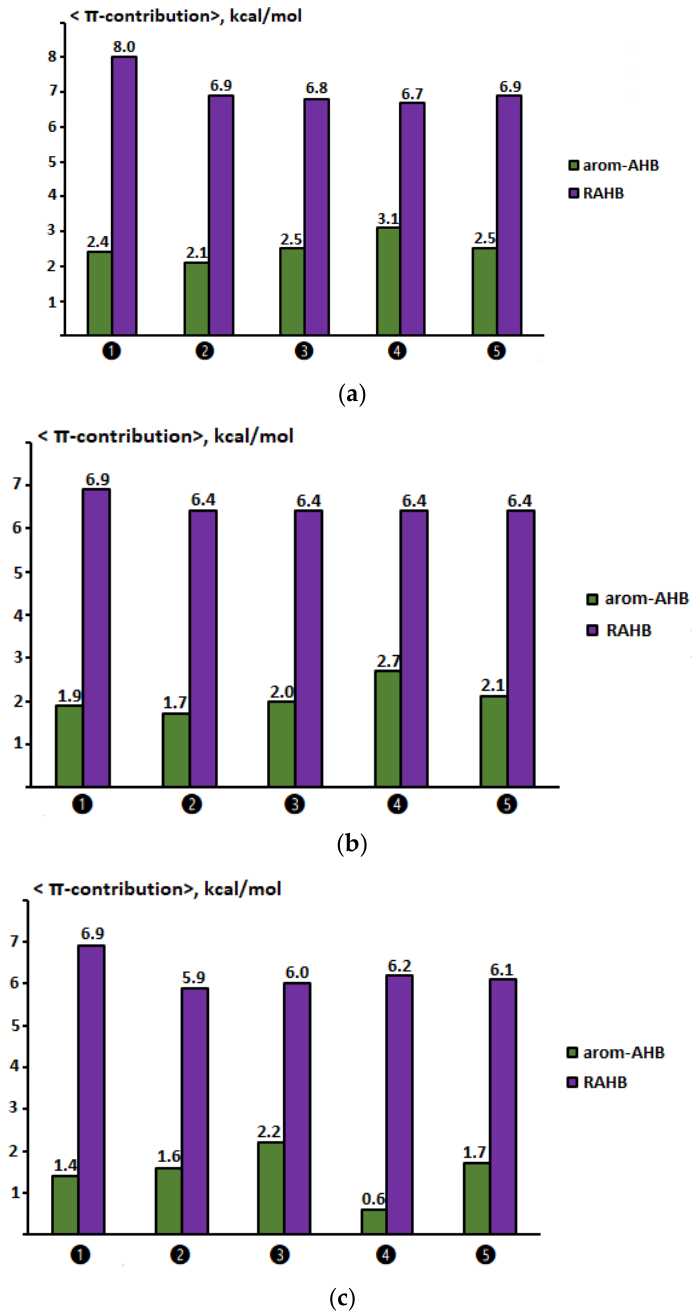
Figure 5. The average value of the π‐ contribution for the total hydrogen bond energy for com ‐ pounds of the arom ‐ AHB and RAHB clusters: range ρ BCP and V BCP — ❶ 0.030–0.035 a.u., ❷ 0.035– 0.040 a.u., ❸ 0.040–0.046 a.u., ❹ 0.046–0.051 a.u., ❺ 0.030–0.051 a.u. (total range), ( a ) and ( b ), re